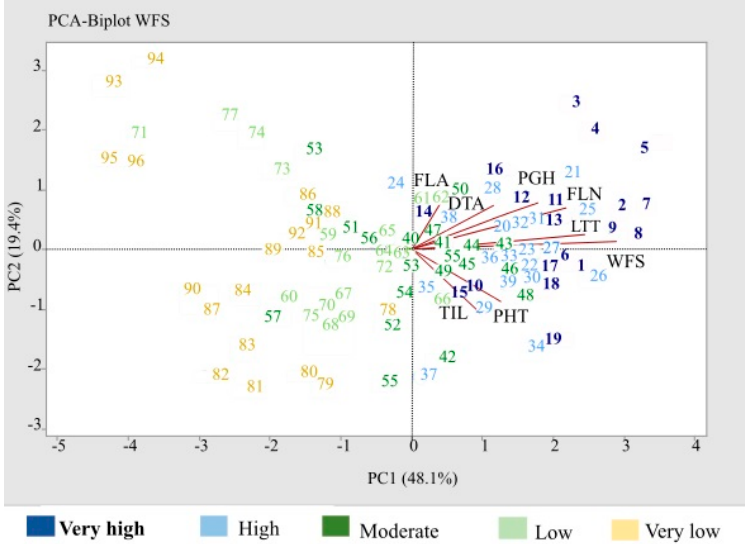
Figure 3. PCA bi-plot of rye genotypes based on PC1 and PC2 components and vectors of traits analyzed in the study. WFS classes for genotypes are indicated by color scheme shown below plot. Genotype numbers refer to Table